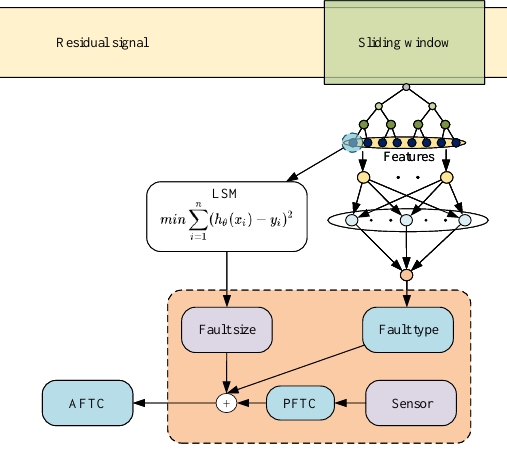
Figure 5. The structure of AFTC